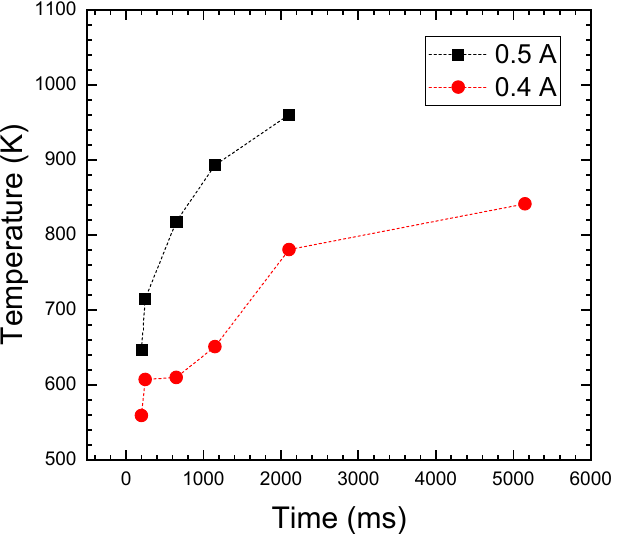
Figure 8. Estimation of temperature during the electrical sintering of silver nanoparticle ink according to 0.5 A and 0.4 A, final-step currents.